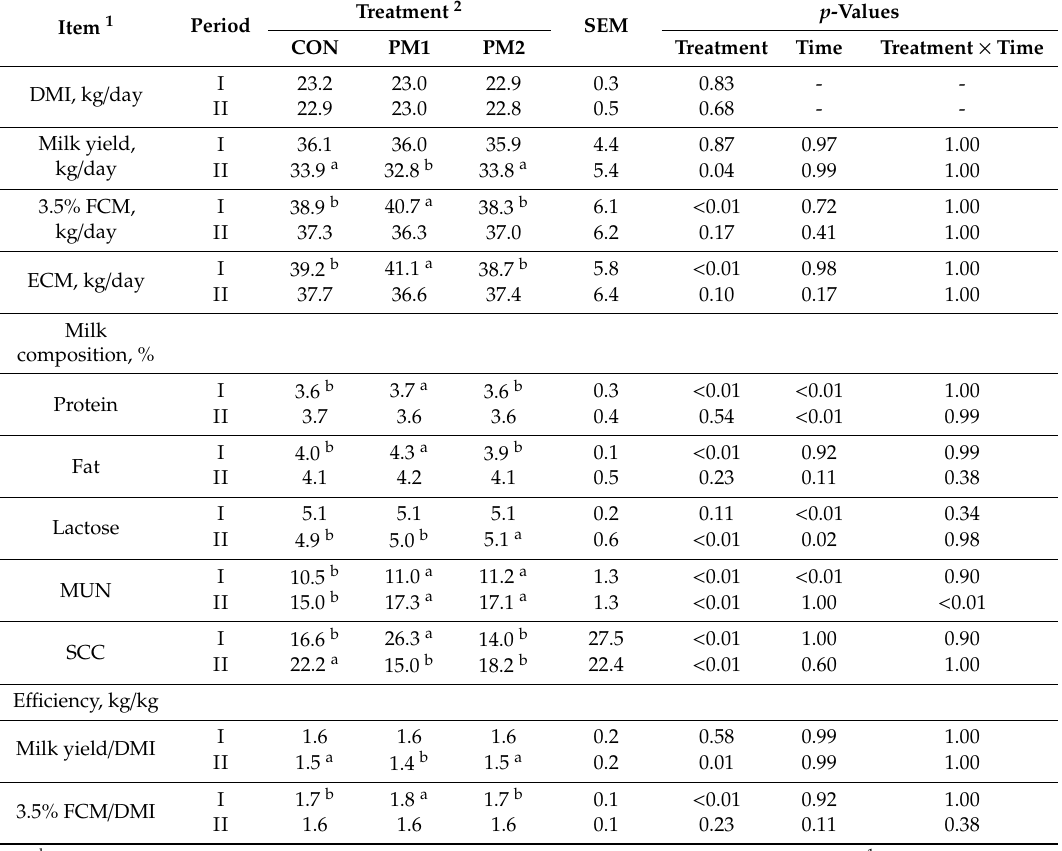
Table 2. E ff ects of paper mulberry silage on the dry matter intake (DMI) and milk yield of dairy